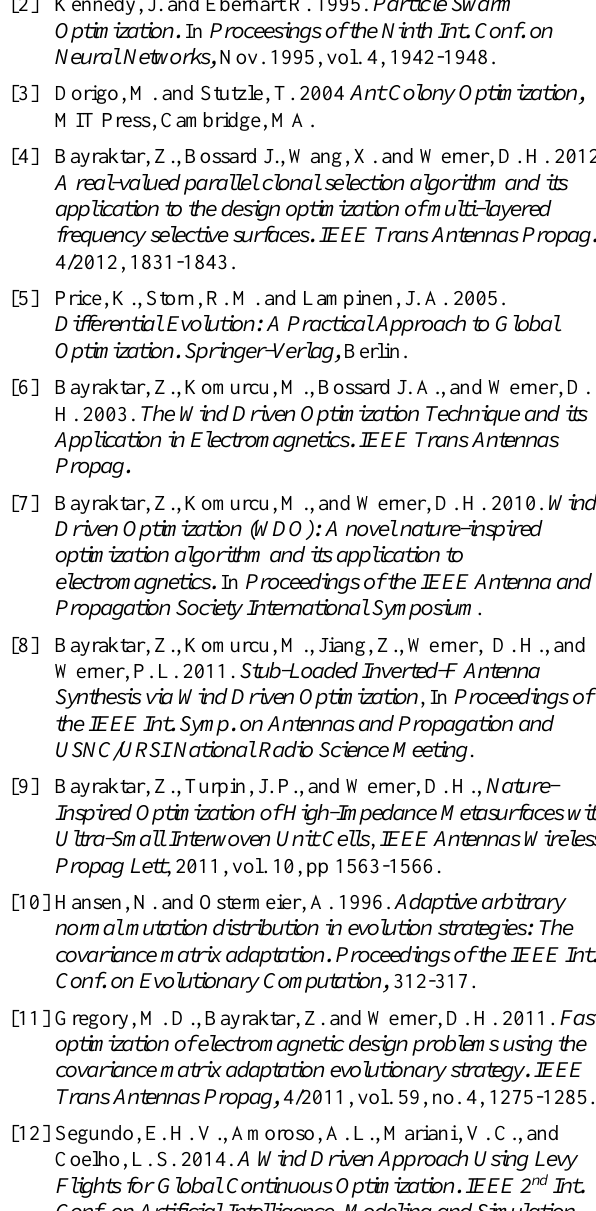
Figure 2. Comparison of mean best pressure for Sphere.